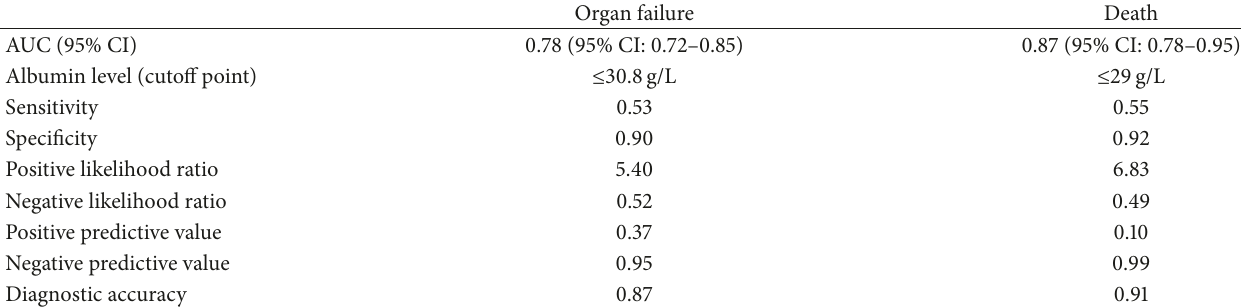
Table 2: The best cut-off values of albumin levels to predict organ failure and death in patients with acute pancreatitis.